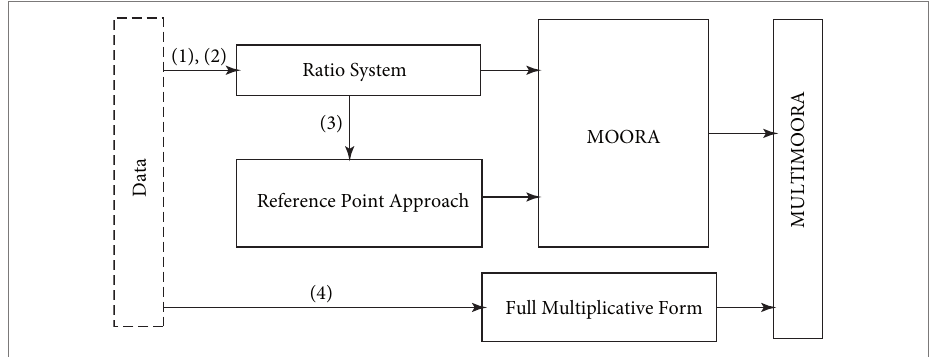
Fig. 2. The procedure of multicriteria evaluation according to the MULTIMOORA method (numbers of respective formulas given in